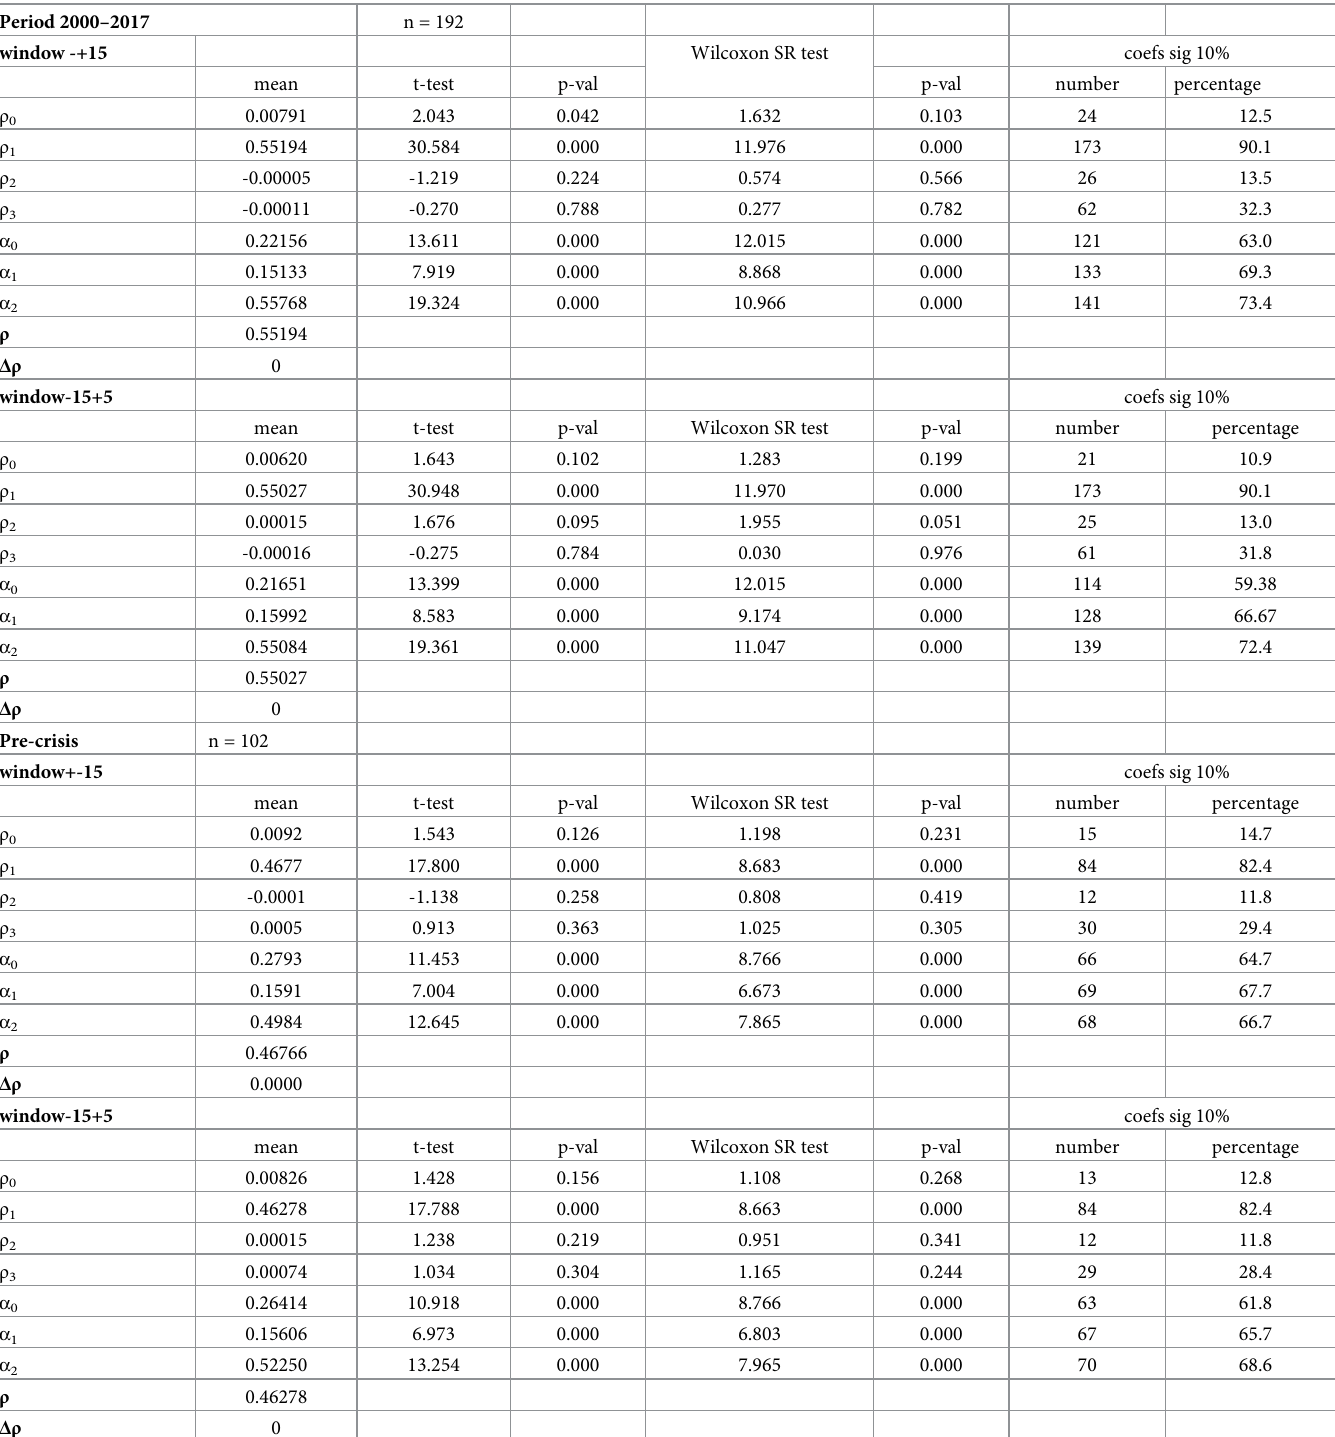
Table 8. Summary results–normalized: